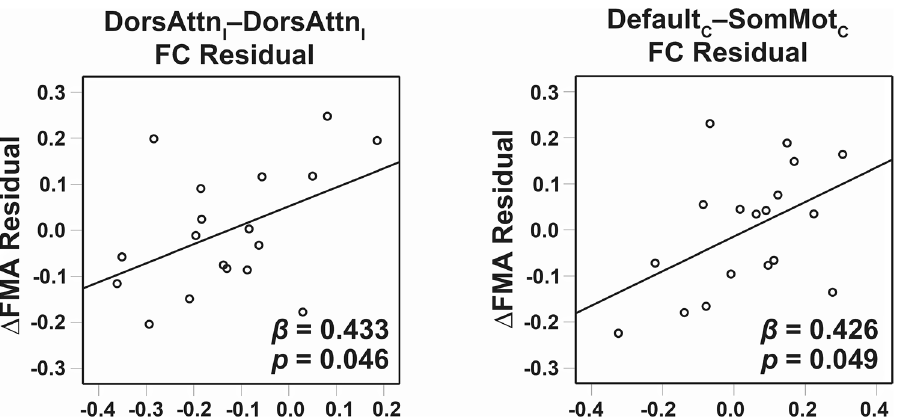
Figure 4. Network-specific functional connectivity of the active-affected task was associated with motor recovery in stroke patients. More FC within ipsilesional DorsAttn network was associated with better motor recovery. More FC between contralesional default and contralesional SomMot was also associated with better motor recovery. C contralesional, DorsAttn dorsal attention, FC functional connectivity, FMA Fugl–Meyer Assessment, I ipsilesional, SomMot